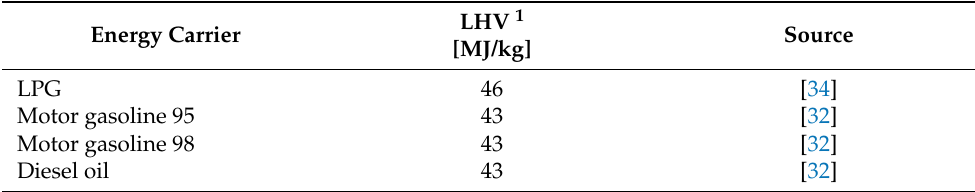
Table 2. Lower heating values of motor